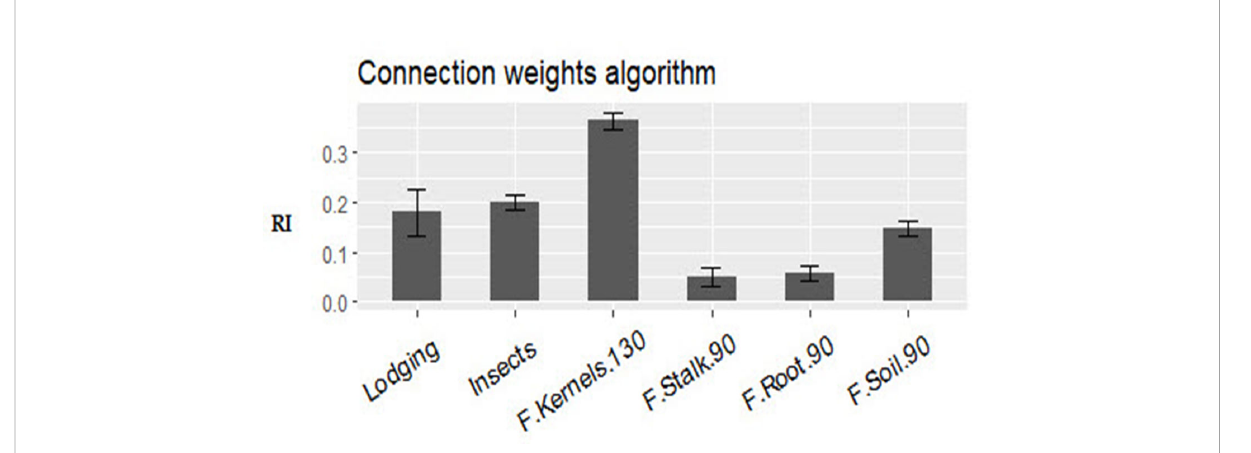
FIGURE 9 The relative importance of the studied traits to the